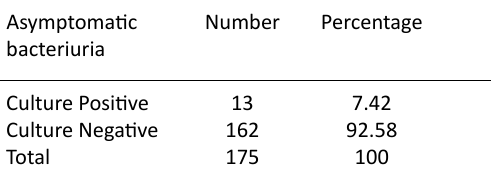
Table 3. Culture for Asymptomatic Bacteriuria Asymptomatic